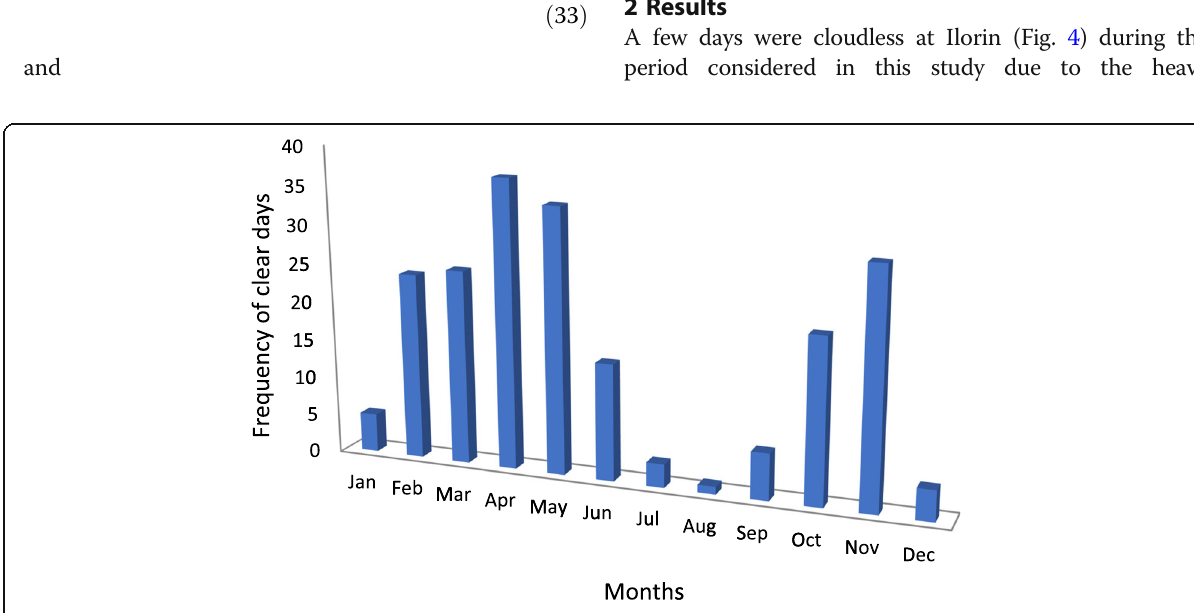
Fig. 4 Monthly distribution of clear days in Ilorin,